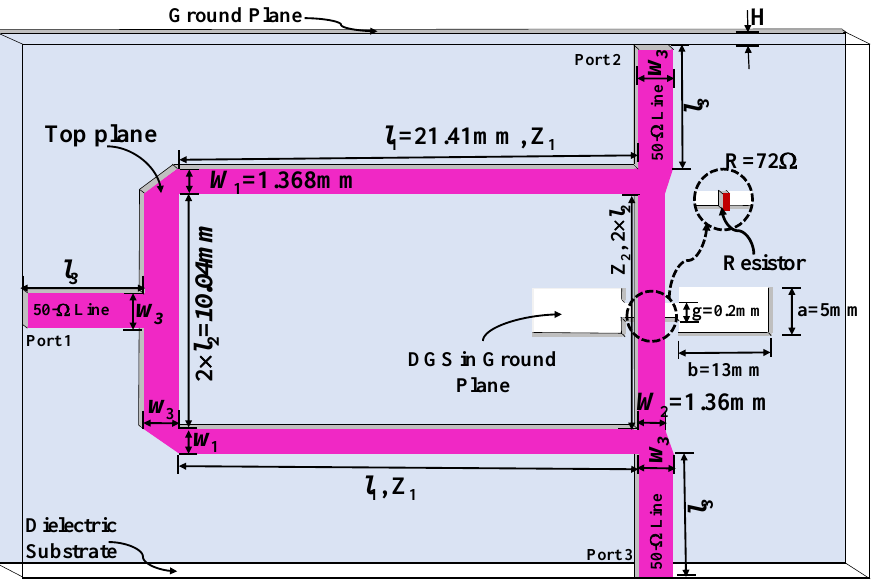
Figure 1. Three-dimensional view of the proposed Wilkinson Power Divider (WPD) at the operating frequency of 3 GHz with the DGS section etched in the ground